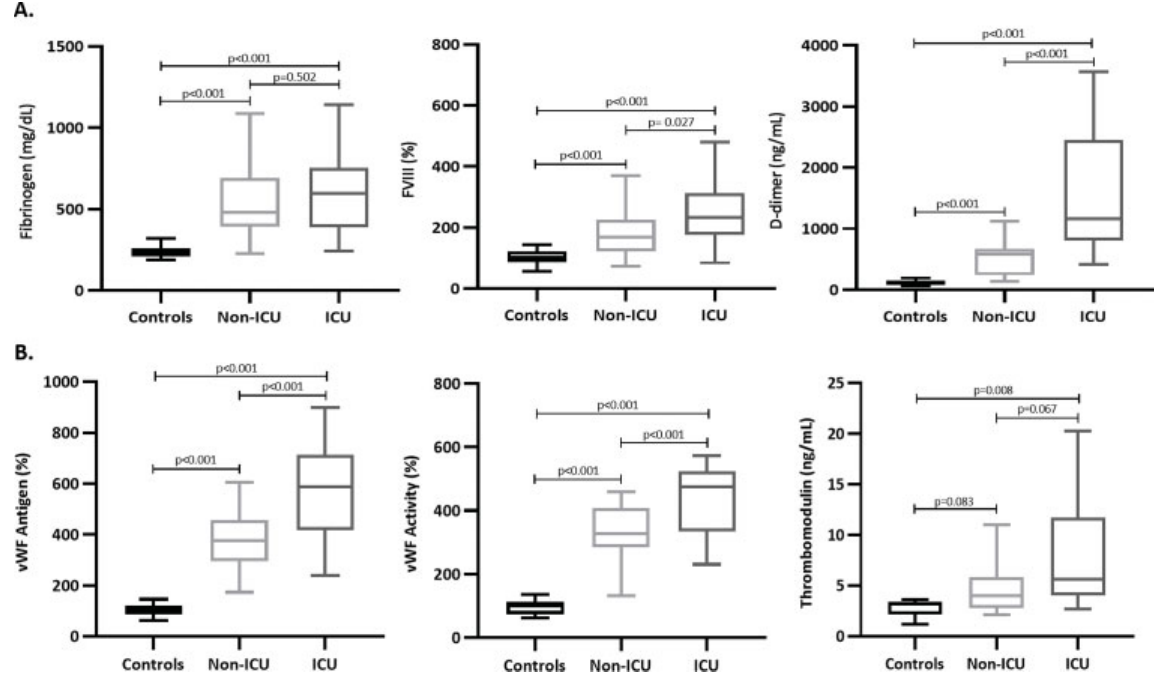
Fig. 1 Hypercoagulability (panel A) and endothelial (panel B) biomarkers in non-ICU and ICU patients compared with controls.